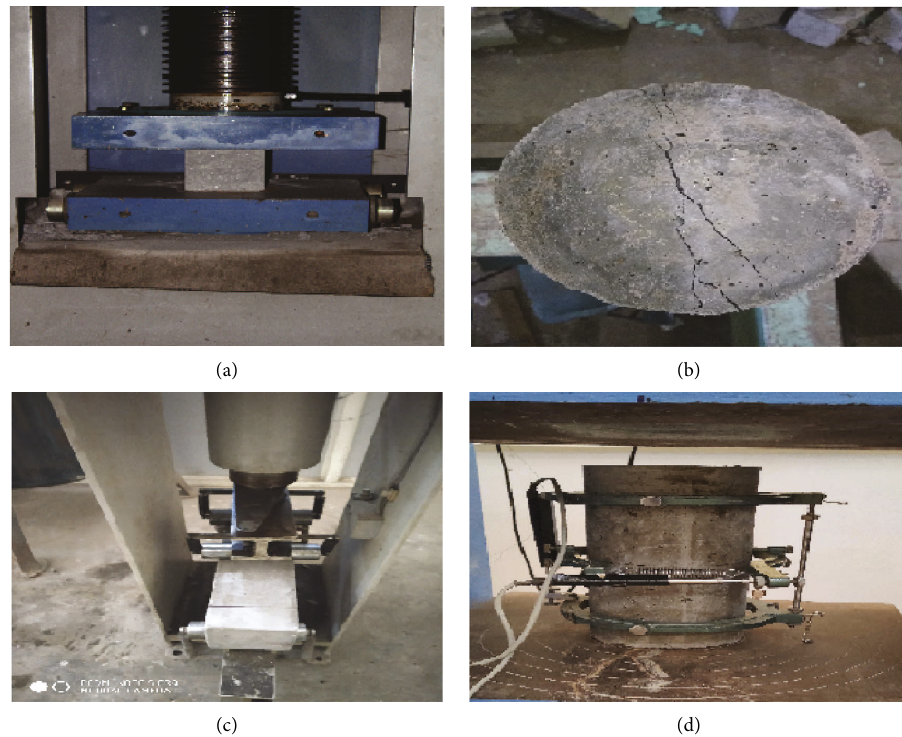
Figure 4: Mechanical properties test pictures of (a) compressive strength; (b) splitting tensile; (c) flexural strength; and (d) Poisson’s ratio and elastic modulus.